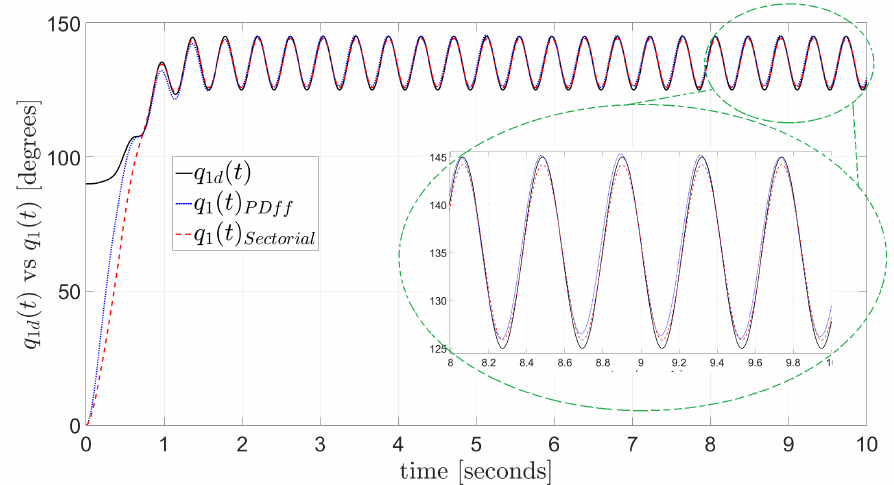
Figure 19. Desired vs. actual position in joint 1.